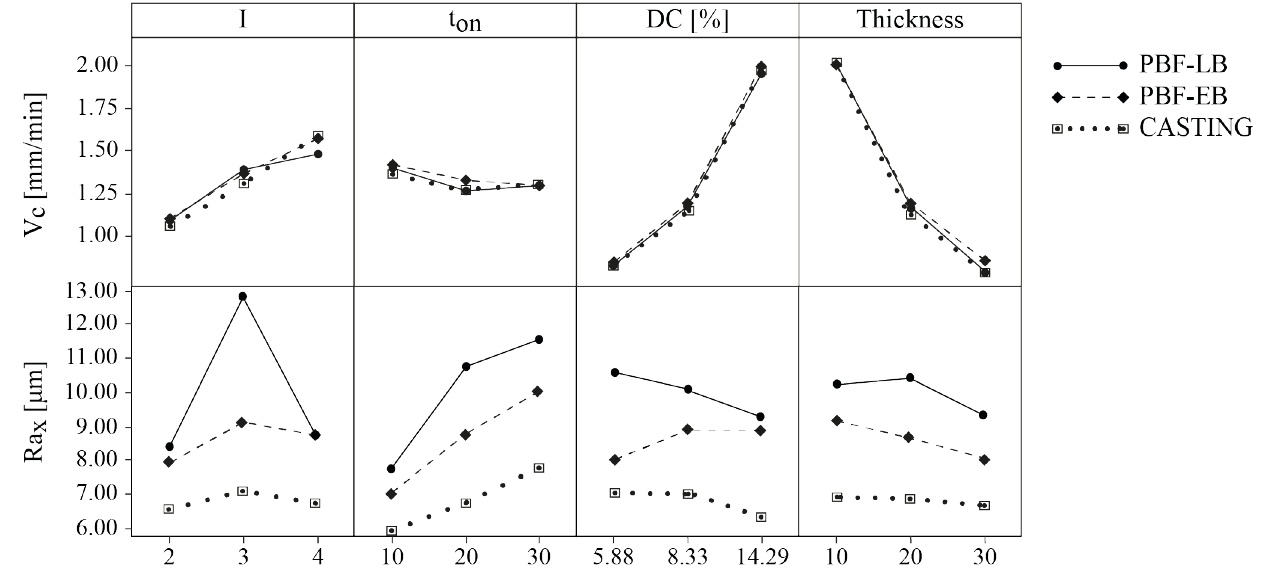
Figure 5. The main effects of process parameters on cutting speed (V c ) and Ra x of all